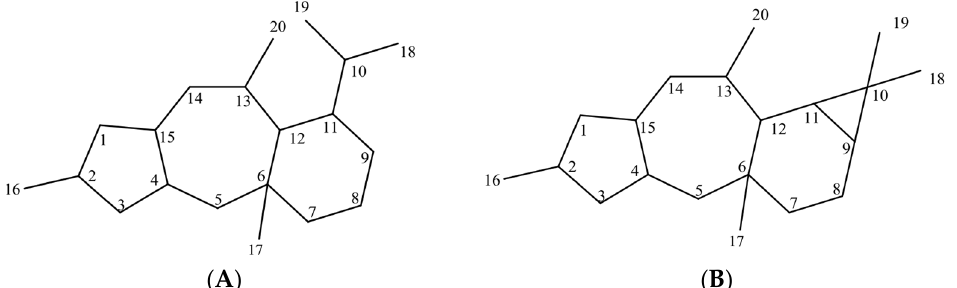
Figure 1. ( A ) Skeletal structure of myrsinanes; ( B ) Skeletal structure of premyrsinanes. They have chemotaxonomic significance and were isolated only from Euphorbia spe- cies, including E. prolifera [6,7], E. sogdiana [8], E. dracunculoides [9,10], E. lathyris [11] E. sanctae-catharinae [12], E. macroclada [13], E. falcata [14,15], and E. aleppica [16] with antifun-